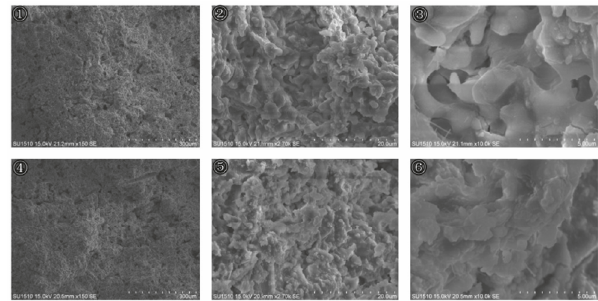
Figure 11: SEM photo of 900 ∘ C sintered samples (HLW pH=7, ABC Fe DEF 9% Fe 2 O 3 free, 2 O 3